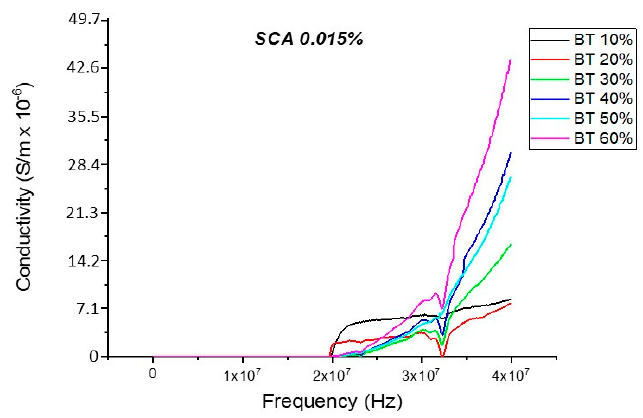
20 of 27 Figure 20. The conductivity of the BaTiO 3 -epoxy composite that were fabricated using BaTiO 3 nanoparticles which were surface modified using 0.010 SCA is plotted as a function of frequency. The maximum value of conductivity at 20 MHz is 4.63 × 10 − 4 S/m and occurs at BT 0.6. There is a decrease in conductivity of the SCA 0.015 and SCA 0.020 surface treated samples by ~73% 20 MHz in 50% BaTiO 3 samples as shown in Figures 21–23. Moreover, the conductivity of the composites decreases as a function of silane coupling agent volume fraction. The pristine or untreated BaTiO 3 tends to adsorb water onto its surface due to its hydrophilic nature [13,14]. The silane coupling surface modification leads to the substitution of the hydroxyl (–OH–) groups on the surface of the BaTiO 3 filler that has a modified surface chemistry of (O–Si–) as shown in Figure 24. As indicated in the FTIR plot in Figure 24, as the concentration of coupling agent increases, more reactions may occur,